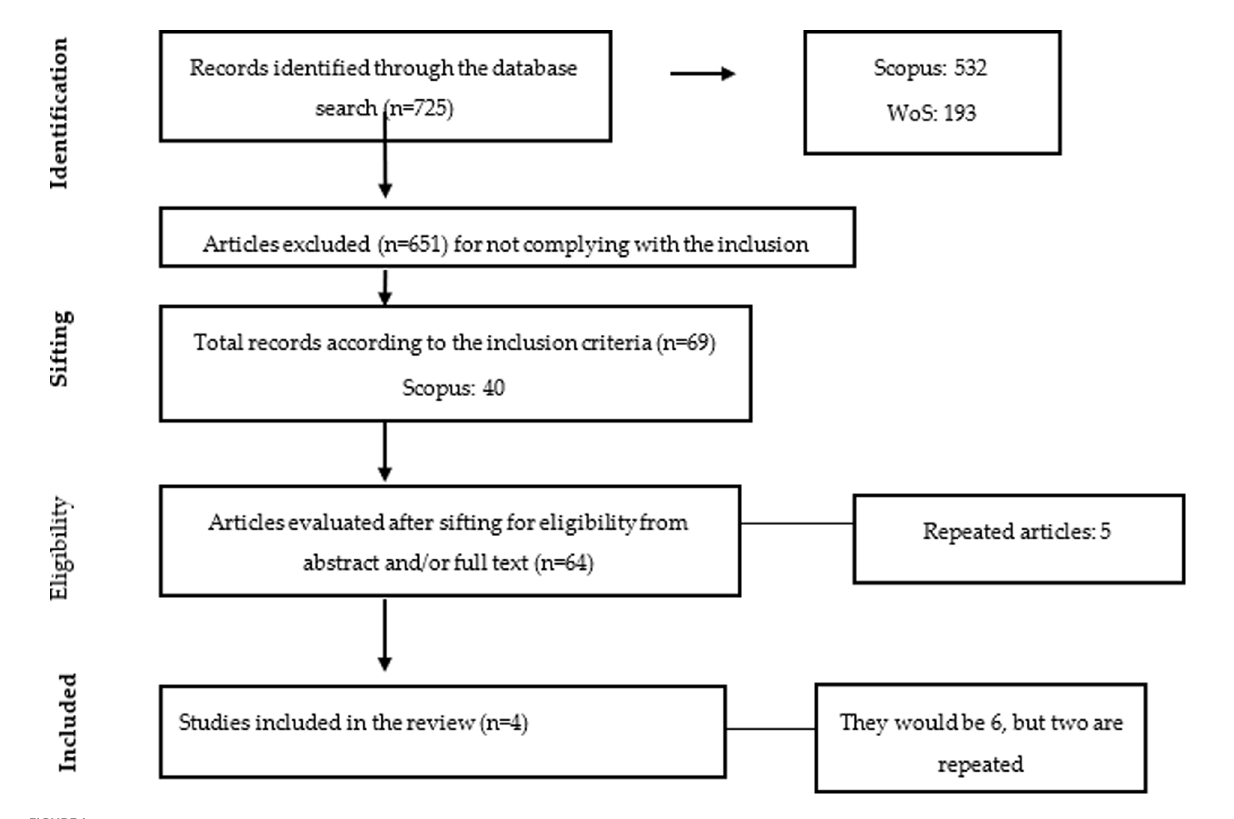
FIGURE 1 Flow diagram used [elaborated by the authors from a template developed by Moher et al. (2009)].